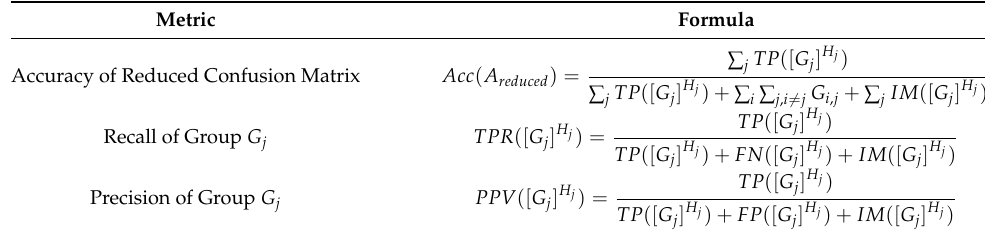
Table 4. Performance metrics of reduced confusion matrix.